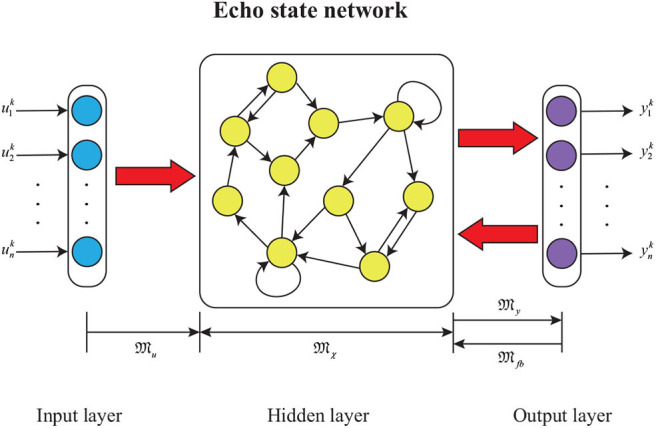
The ESN diagram.